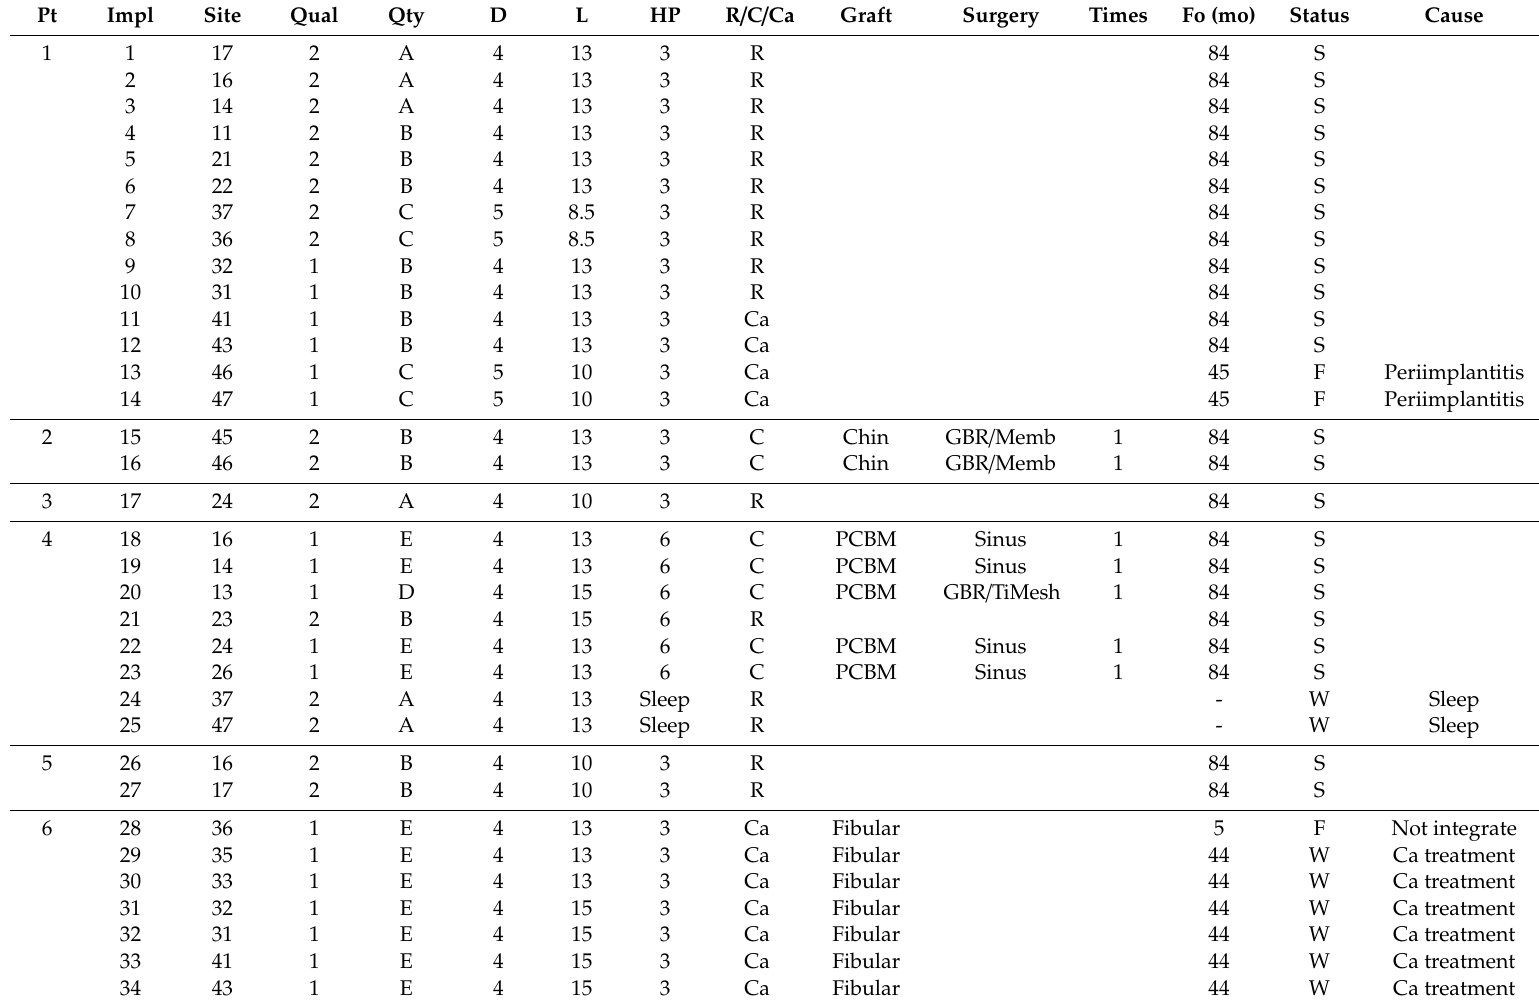
Table 2. Implant profiles used in the present